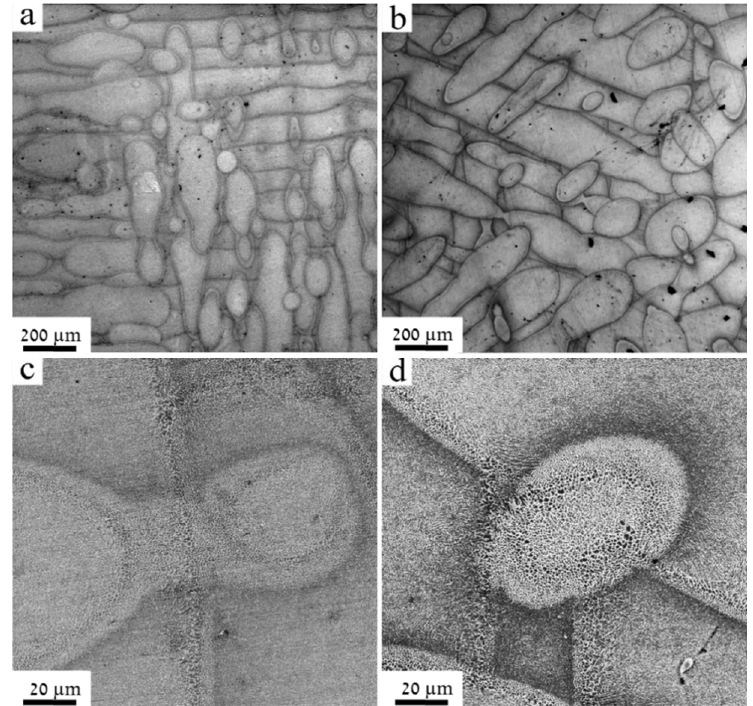
Figure 6. Building surface of SLM–AlSi10Mg part manufactured along the Z orientation, using ( a ) CL and ( b ) EOS techniques, respectively. Images ( c ) and ( d ) are enlarged micrographs of ( a ) and ( b ), respectively.